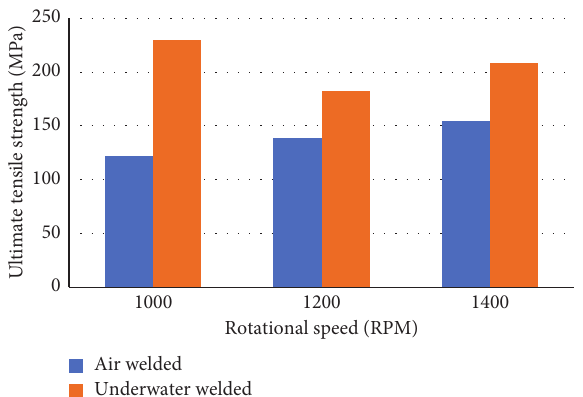
Figure 3: Comparison of tensile strength for air welded and underwater welded FSW samples at 36 mm/min. Table 4: Limiting stress ratio criterion. Sample no.